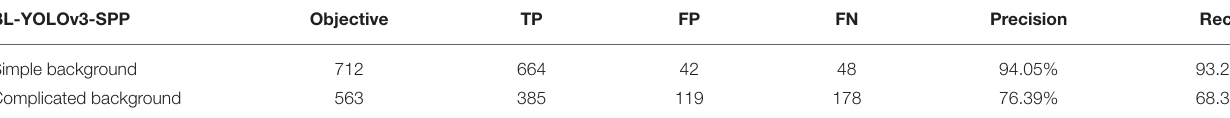
TABLE 6 | The statistical results of the detection of different background for test_orchard.